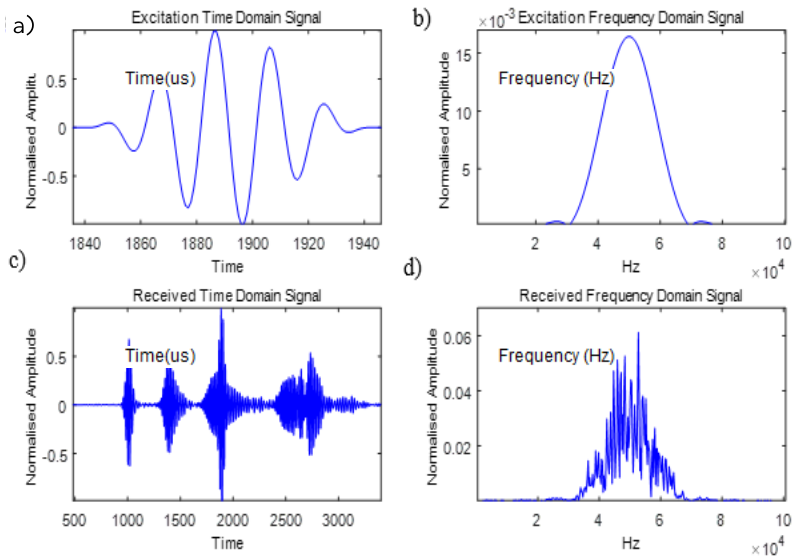
Figure 1. guided wave testing (GWT) signals: an excitation ( a ) time domain and ( b ) frequency domain signal, received ( c ) time domain and ( d ) frequency domain signal.